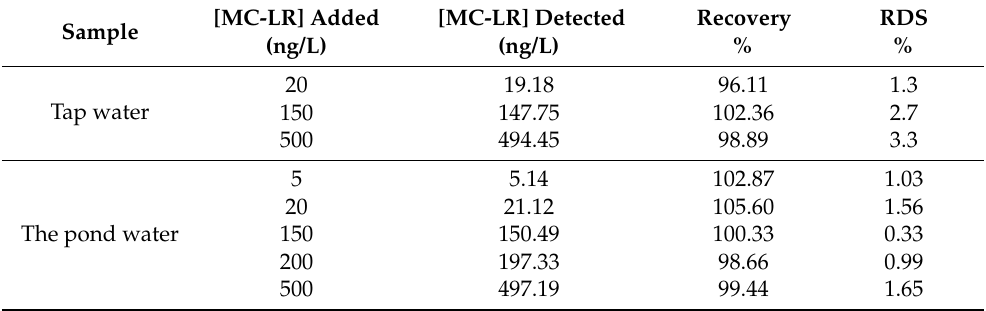
Table 2. The recoveries of simulated samples were detected by labeled E − AB